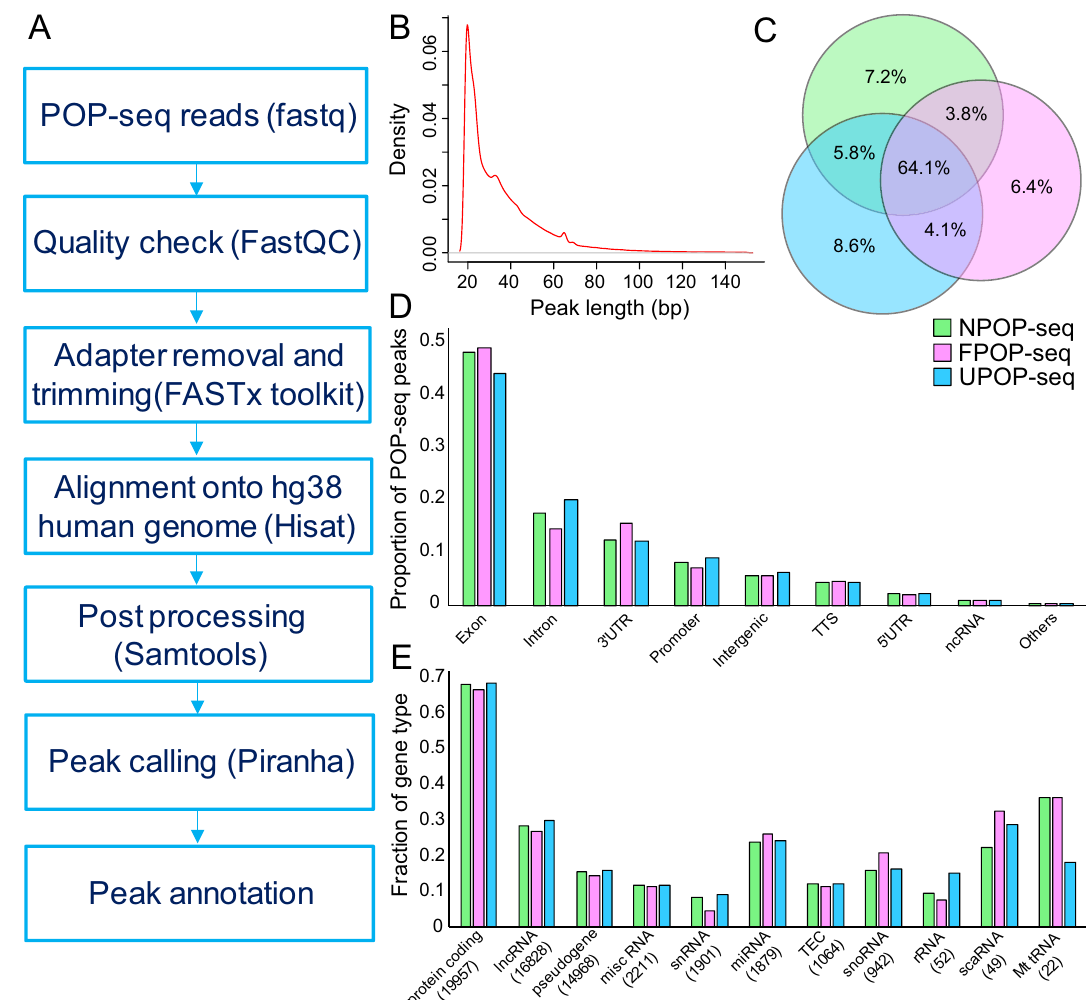
Figure 2. Statistical analysis of POP-seq dataset. (A) workflow for POP-seq data processing and downstream analysis. ( B ) A density plot showing the distribution of POP-seq peaks length (bp). ( C ) Venn diagram showing the overlap of genes exhibiting POP-seq peaks across the protocols. ( D ) Proportion of POP-seq peaks in genomic elements. ( E ) Fraction of gene types captured by